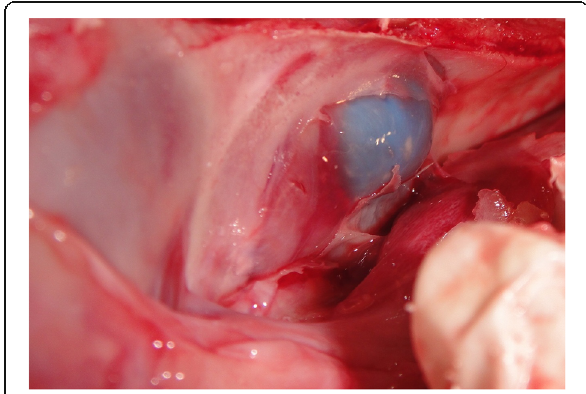
Fig. 4 The inflated balloon while elevating the sinus membrane (The balloon is seen from the medial.)